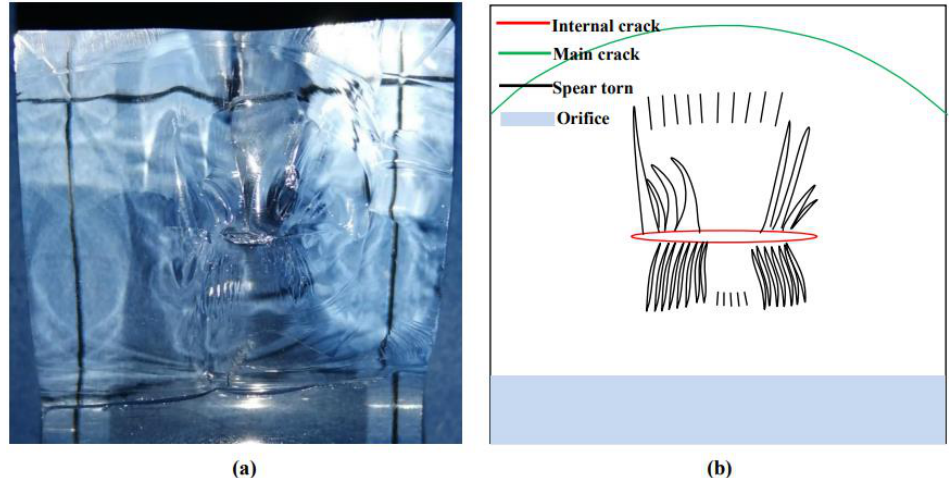
Figure 14. Main crack “penetrating” prefabricated crack. ( a ) Experimental results; ( b ) Schematic